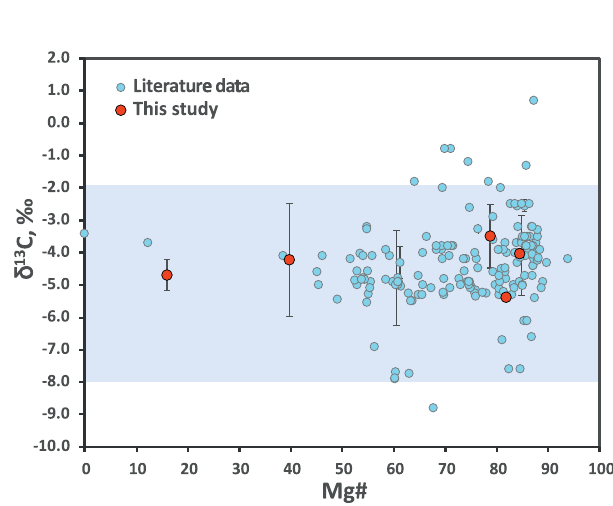
red sextet corresponds to Fe 2.5+ ; i.e., Fe 3+ ↔ Fe 2+ rapid electron hopping between octahedral sites of magnesioferrite. B Green and blue doublets correspond to Fe 2+ in the octahedral site of magnesiowüstite.